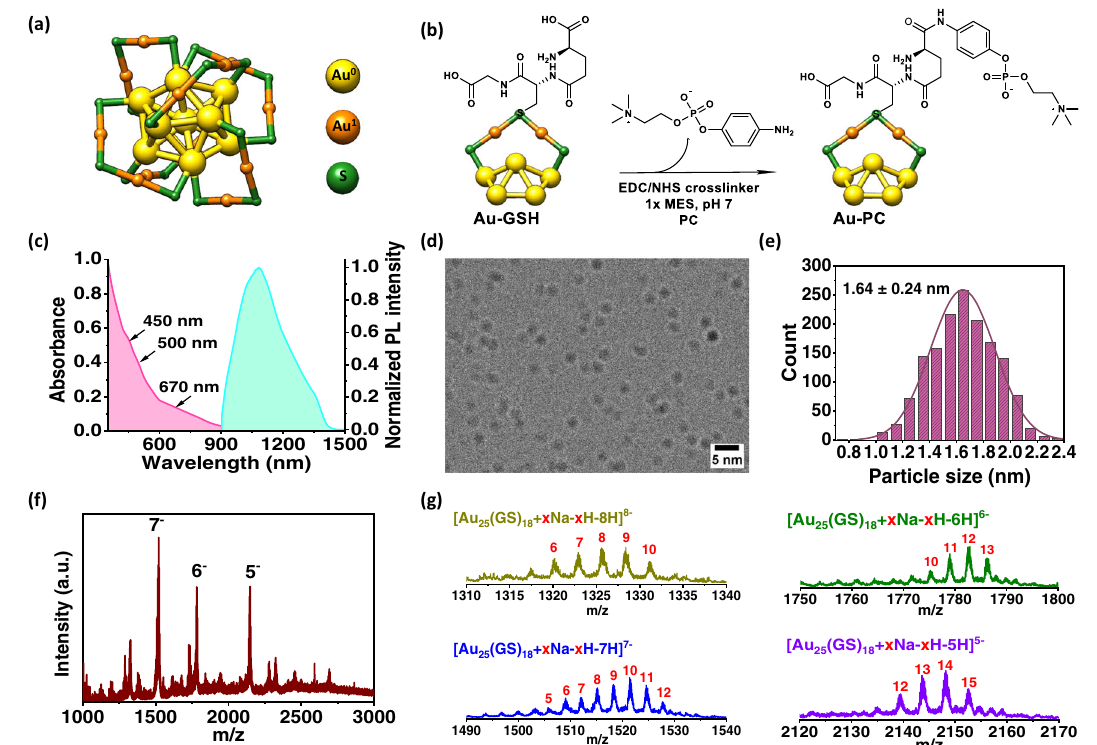
Fig. 1 | Characterization and functionalization of Au-GSH clusters. a Crystallographic representation of Au 25 cluster structure. Color codes of the ele- ments: Au (0) in the core: yellow, Au (I) in the staple motif: orange, S in the staple motif:green.ThestructurewaspreparedusingUCSFChimeraprogram(version1.12) basedoncrystalstructuredatapublishedinReference46. b Postfunctionalizationof Au-GSH cluster and schematic representation of Au-PC conjugate structure. For clarity,onlyonestaplemotifandadjacentgoldcoreatomsareshown.Forsimplicity, the conjugation of PC ligand to glycine carboxylic group is omitted and it is only shown with γ -glutamate carboxylic functional group of GSH. c UV-vis absorption